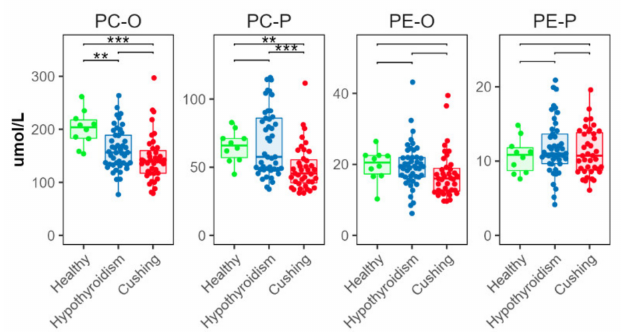
Figure 4. Total abundance of species from ether (alkyl, -O) and plasmalogen (alkenyl, -P) phos- phatidylcholine (PC) and phosphatidylethanolamine (PE) classes. Levels of statistical significance between two groups calculated by two-tailed Welch’s t -tests are indicated with stars: ** p ≤ 0.01 and p > 0.001, *** p ≤